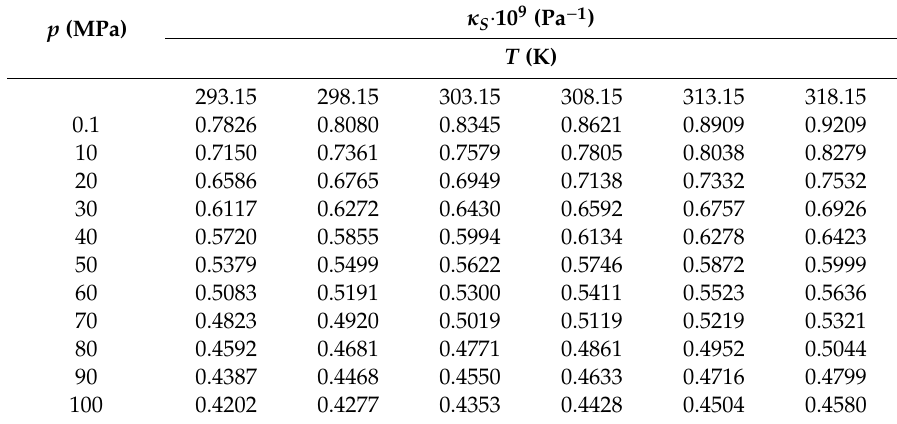
Table 7. The isentropic compressibility, κ S , of 1-butanol at pressures up to 100 MPa and within the temperature range from (293 to 318) temperature range from (293 to 318) K.